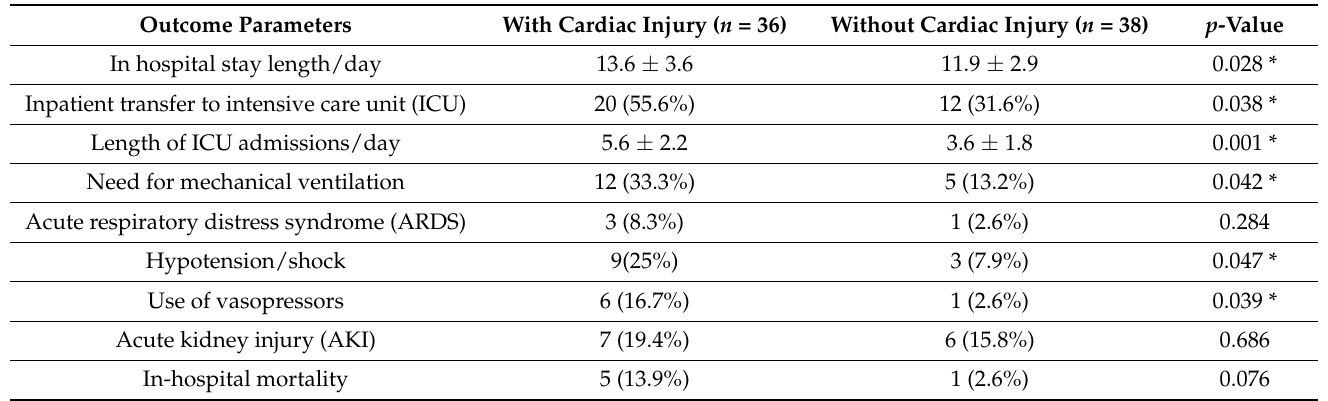
Table 3. Outcome parameters in patients with and without cardiac